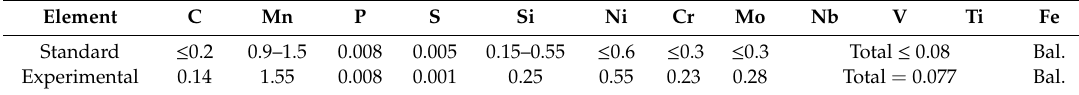
Table 1. Chemical compositions of the steel SA738 Gr.B in ASME standard and this experiment (mass Table 1. ChemicalcompositionsofthesteelSA738Gr.BinASMEstandardandthisexperiment(massfraction,%). fraction,%).